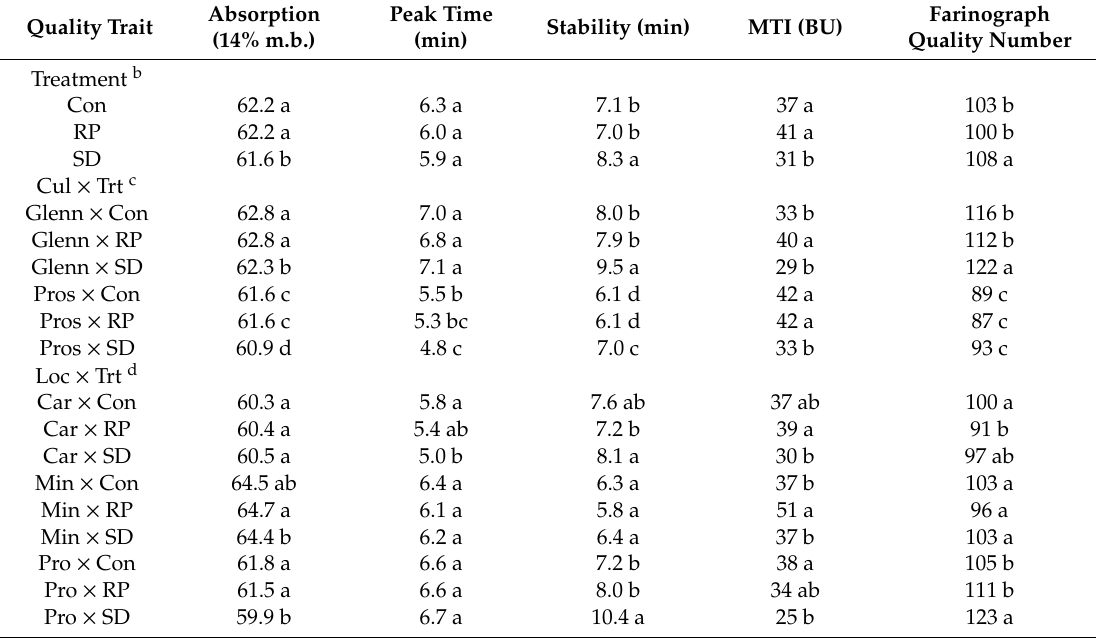
Table 2. Farinograph dough quality parameters, as a ff ected by treatments and their interactions a . Absorption Peak Time Stability (min) MTI (BU) Quality Trait (14% m.b.) (min)